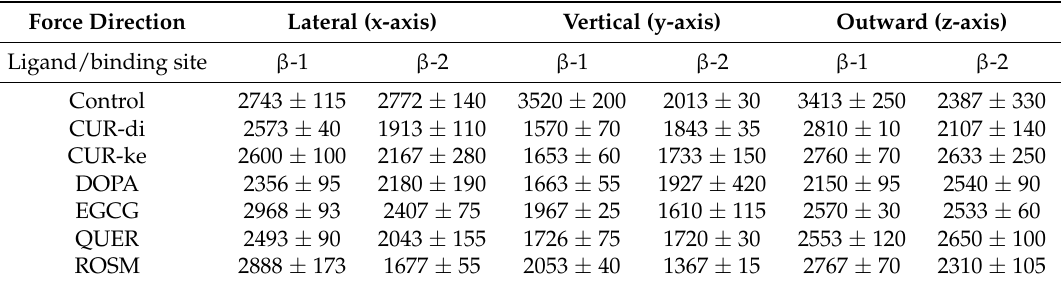
Table 2. Computed force (expressed in kJ/mol) needed for protofibril(1)–protofibril(2) (control) and